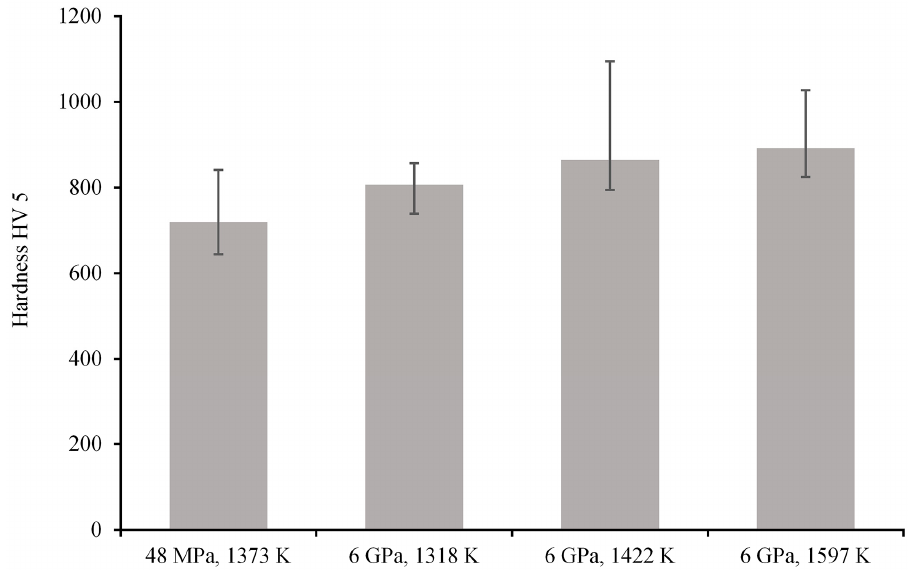
Figure 6. Hardness of the Ti–10Al–20Si alloy prepared by SPS and HP SPS at various temperatures.